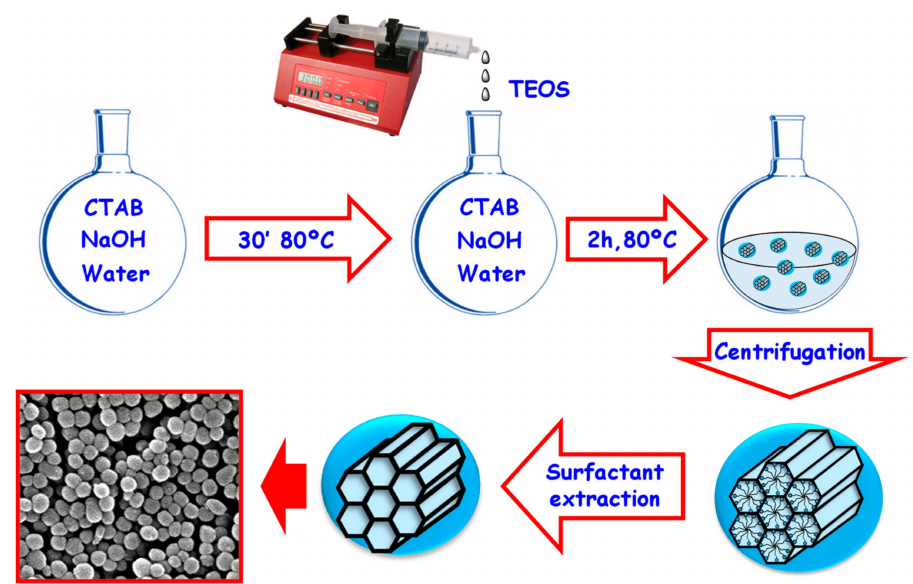
Figure 1. Synthesis of MCM-41 MSNs using a modification of the Stöber method. The surfactant molecules self-assemble forming rod-like micelles around which the silica precursors polymerize, leading to the formation of a silica backbone with hexagonally ordered mesopores. TEOS: Tetraethyl ortosilicate; CTAB: Cetyltrimethylammonium